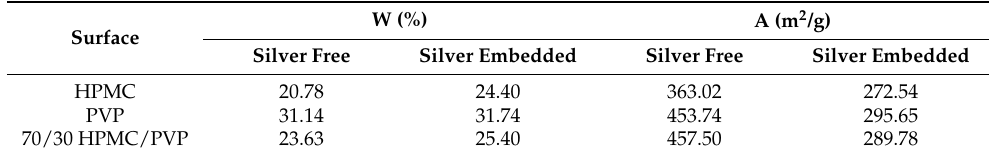
water vapor sorption capacity, W, and specific surface area, A, evaluated using the BET